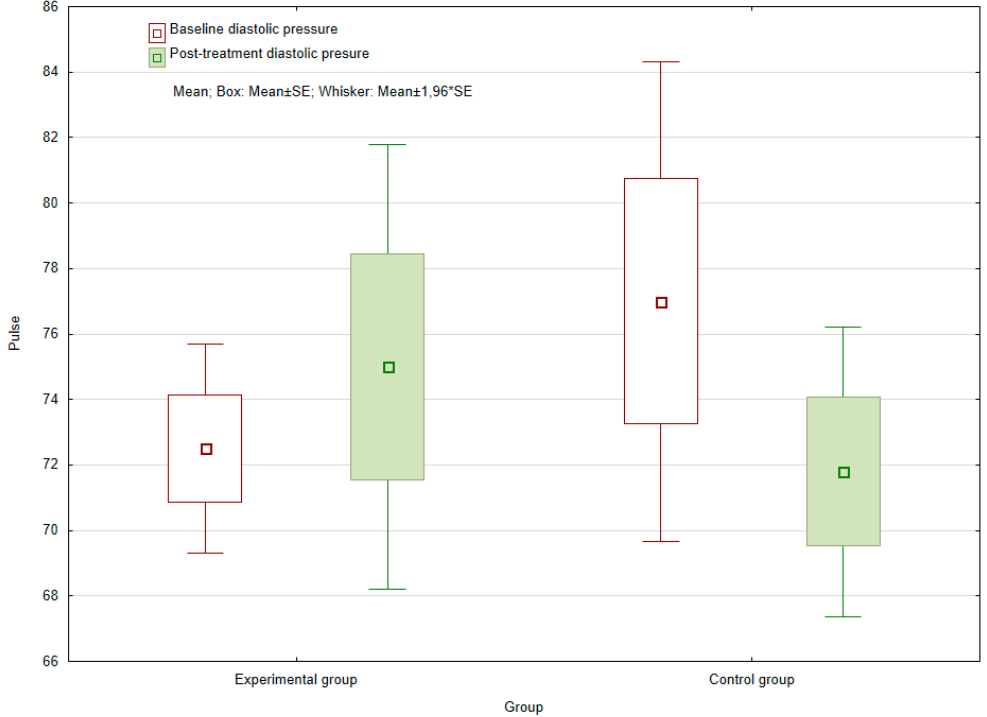
Figure 2. Baseline and post-treatment diastolic blood pressure of the experimental and control groups.